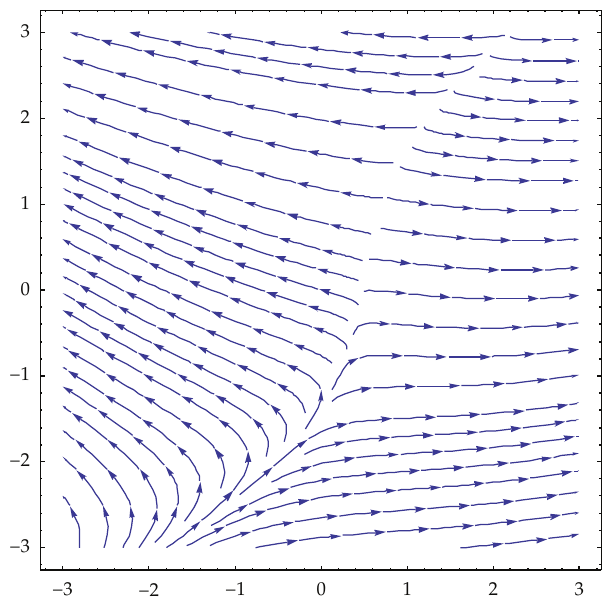
Figure 2: The graph of the vector fields (cid:3) V 1 ,V 2 (cid:4) ∇ on T (cid:7) Z